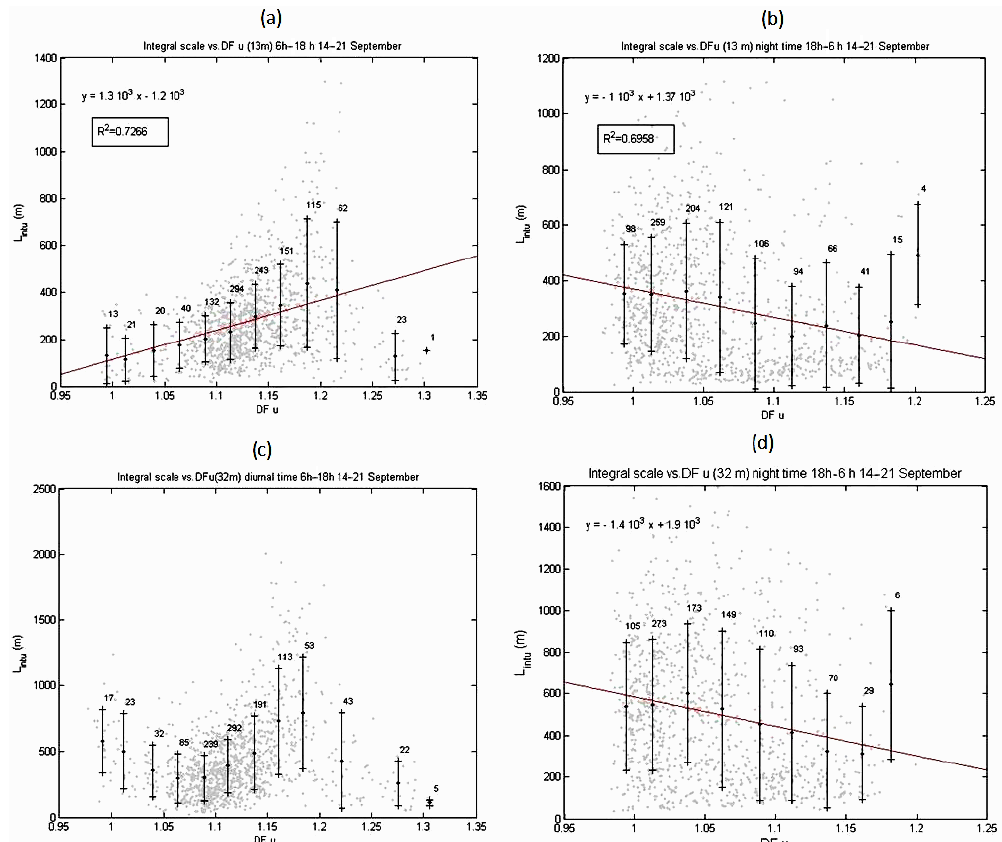
Figure 6. Variations of the integral scale vs. the fractal dimension of the u (cid:48) component at 13 and 32m. (a) and (c) diurnal hours, (b) and (d) night hours. In the same manner as in Fig. 5, the linear fits are (a) L intu (13m) = 1 . 3 × 10 3 DF u (13m) − 1 . 2 × 10 3 , (b) L intu (13m) =− 1 × 10 3 DF u (13m) + 1 . 37 × 10 3 , and (d) L intu (32m) =− 1 . 4 × 10 3 DF u (32m) + 1 . 9 × 10 3